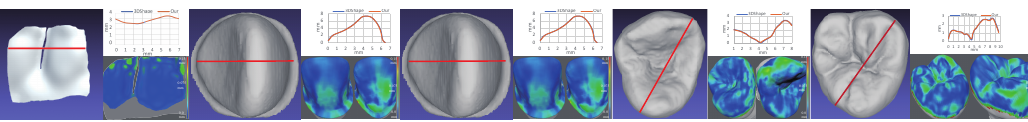
Figure 6. This illustrates the precision analysis when using the model constructed by the state-of-art digital intraoral scanner Carestream’s CS 3600 [4] as ground truth for the living incisor and the isolated incisor, premolar, and molar teeth, where the average deviations are 8.71, 27.3, 28.4, and 30.6 µ m, respectively, and the maximal are 38.3, 263, 135, and 235 µ m, respectively. The left shows the reconstruction surface; the right top shows the visualization of height differences at the cutting line, where blue marks the results reconstructed by the state-of-art, and red marks those by ours; and the right bottom visualizes the reconstruction errors while comparing to the model generated by the state-of-art using the rainbow coloring scheme.